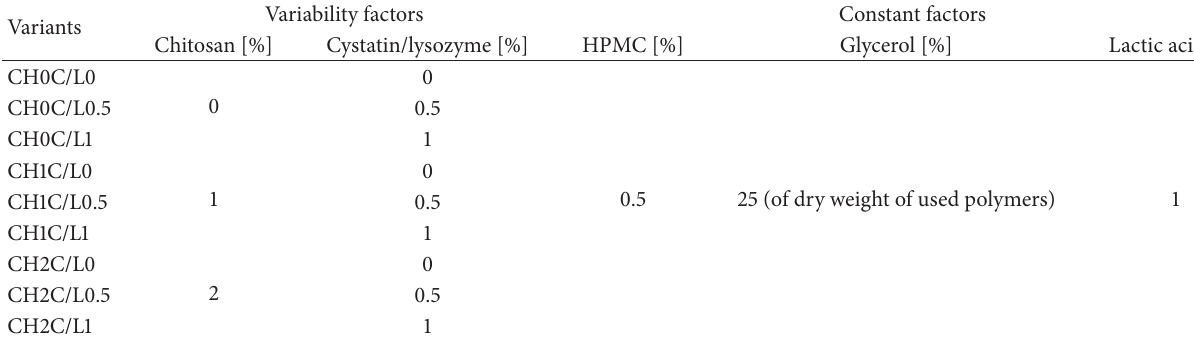
Table 1: Experimental design of film forming